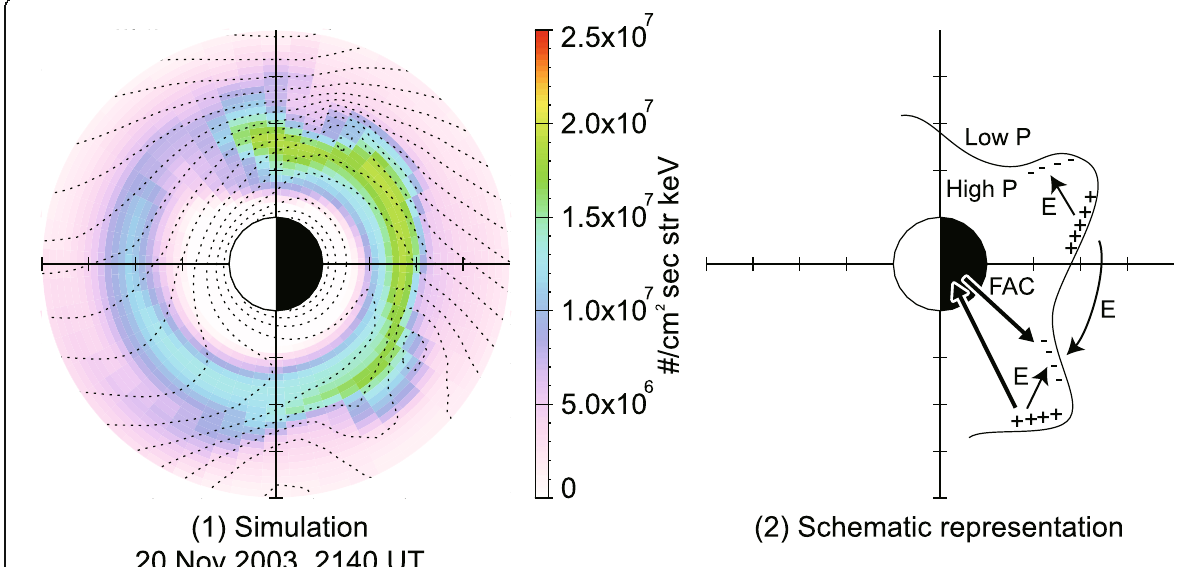
Fig. 13 Influence of ring current-ionosphere coupling on the ring current protons in terms of Rayleigh-Taylor type instability. Proton flux with energy 32 keV is shown in the left panel. The outer edge of the flux population shows undulation due to interaction between the magnetosphere and the ionosphere. The contour indicates the ionospheric potential. The schematic illustration is provided in the right panel. (After Ebihara et al.